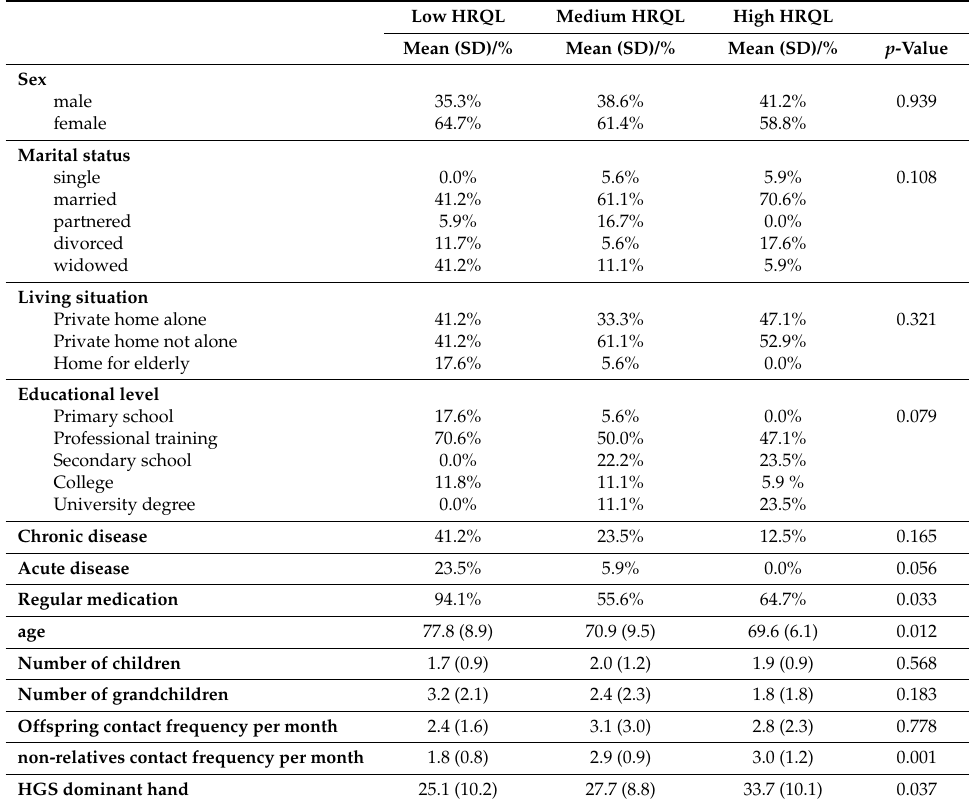
Table 3. Sample characteristics according the level of health-related quality of life. Kruskall-Wallis tests, χ 2 . Low HRQL Medium